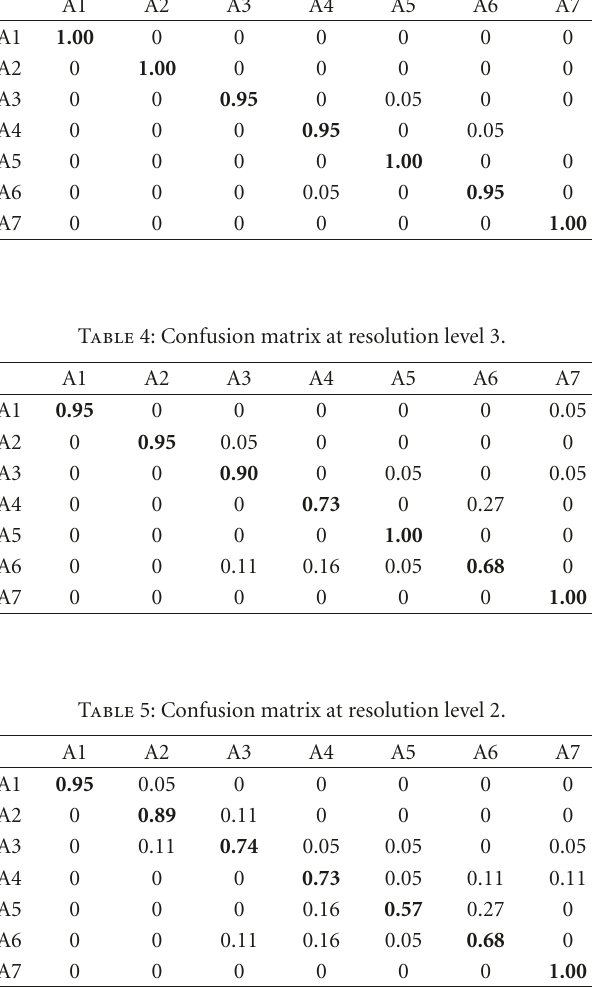
the computational e ffi ciency. Table 7 tabulates the average number of bins for di ff erent actions at di ff erent resolution levels. We can find that at resolution level 5, the average number of bins falls from 168.2 to 268.4, which are much less